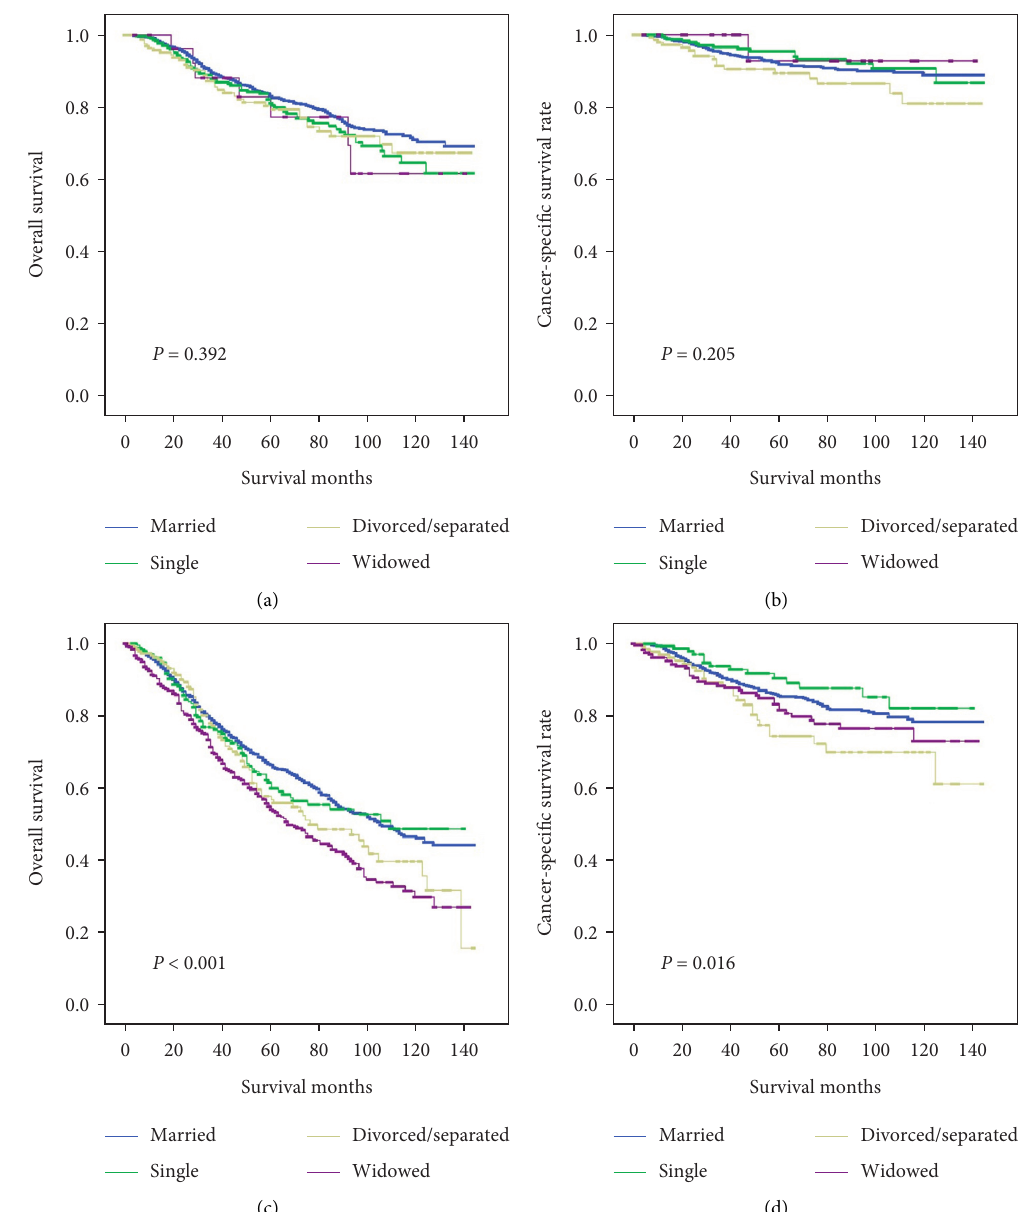
Figure 5: Kaplan–Meier comparison of OS and CSS among patients stratified by age at diagnosis. (a, b) Patients lower than 60years old and (c, d) patients older than 60years old. Table 8: Multivariate analysis for evaluating the influence of marital status on OS according to age.